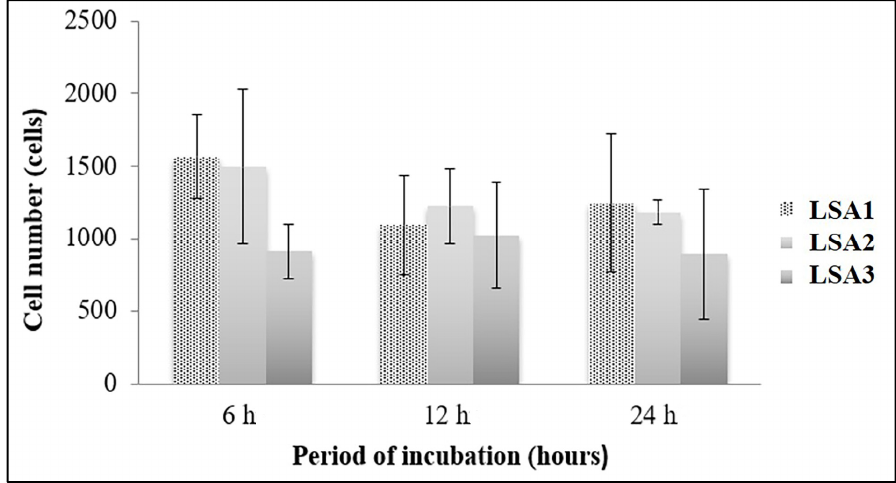
Figure 6. MG-63 cell attachment to lithium disilicate glass-ceramics with various Al 2 O 3 . MTT assay of MG-63 cells attached to lithium disilicate glass-ceramics with various Al 2 O 3 for 6 h, 12 h, and 24 h. There was no statistical difference among glass-ceramics types and time points.